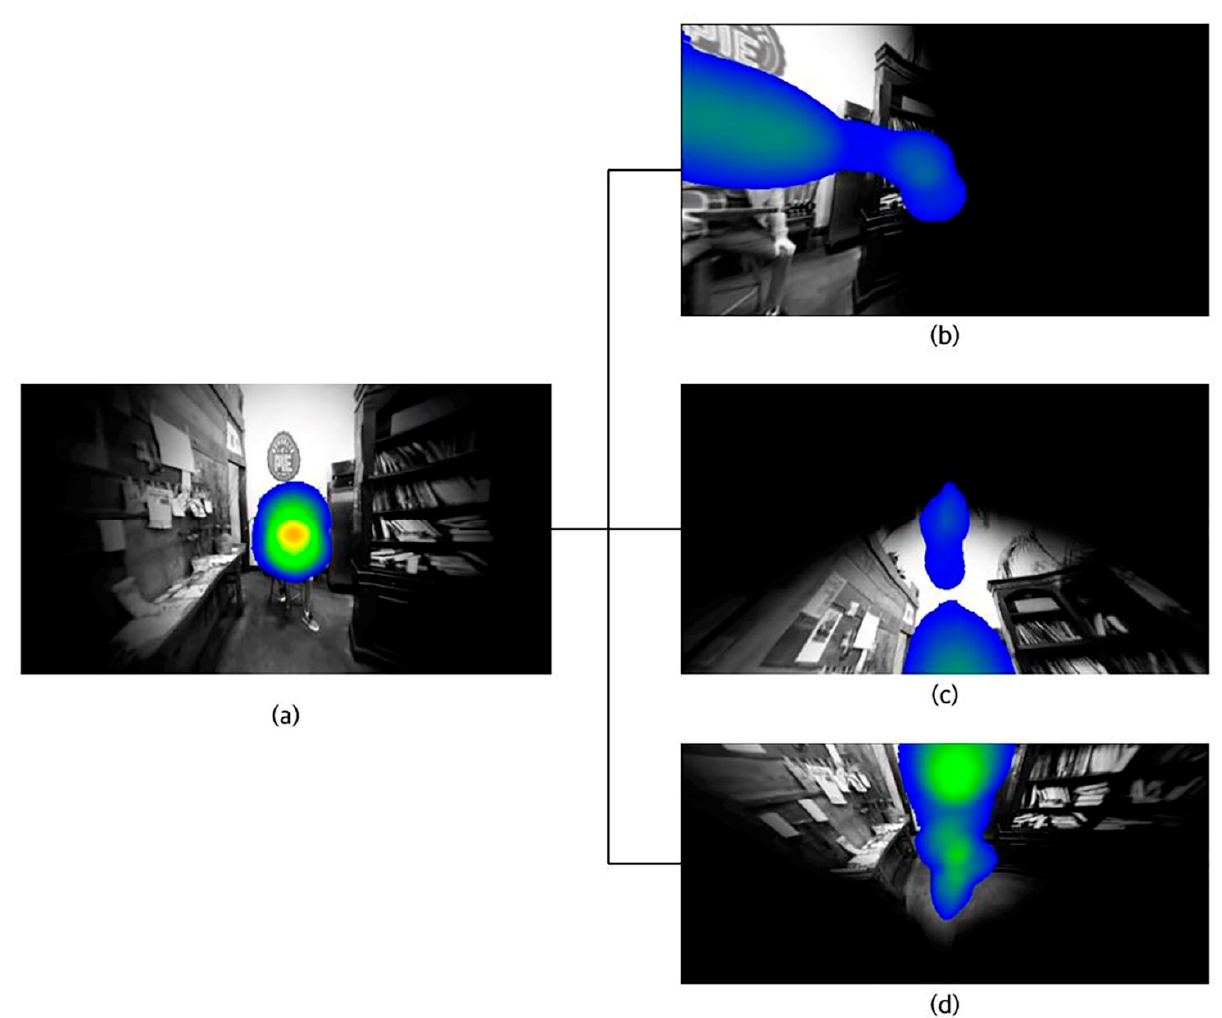
Figure 20. Eye movement according to attention-attracting element of ”Gaze angle variation”. ( a ) At the beginning of the video, most subjects’ attention is fixed on object A, which is positioned in the center, ( b – d ) The subject’s attention moves along with the edge of the widening gaze angle.